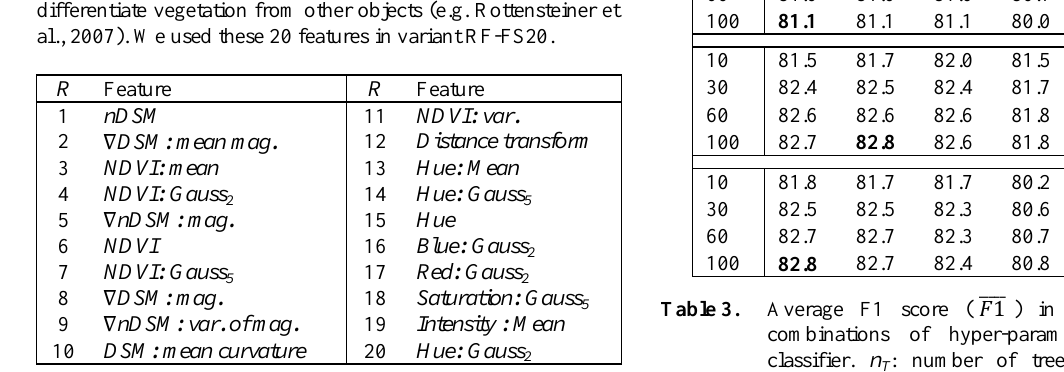
Table 2. The 20 most important features. R : Rank.